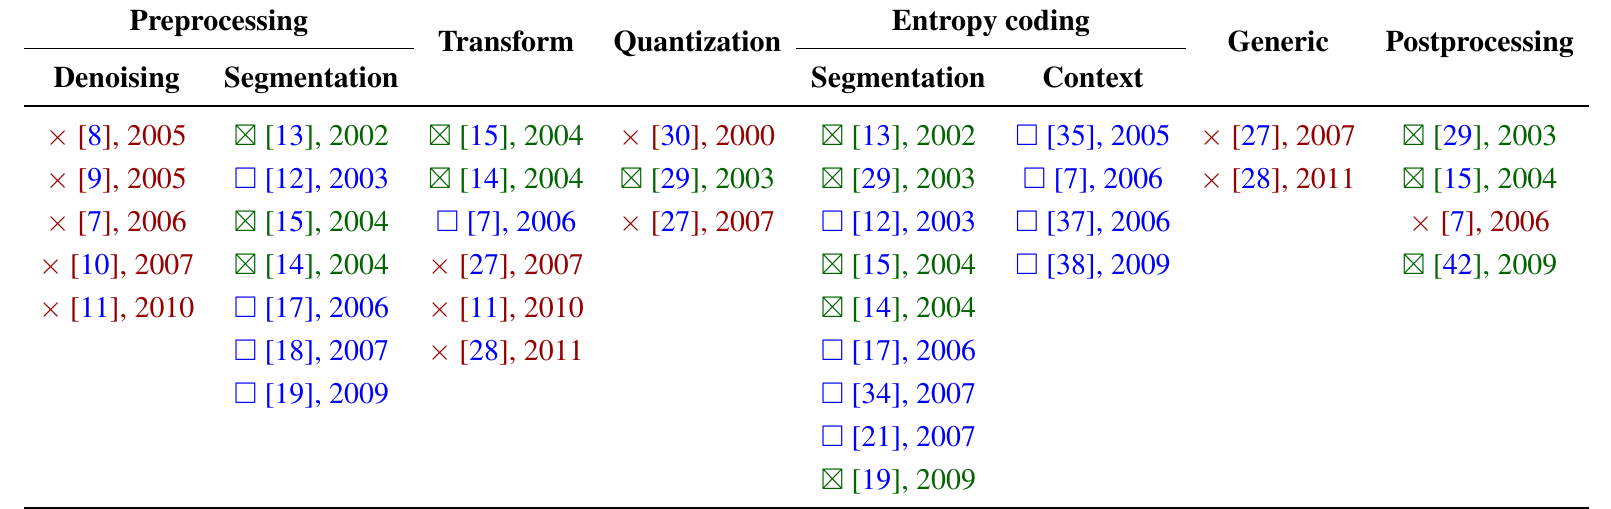
Table 1. Classification of microarray-specific techniques discussed in this document, attending to the compression stage where they make their contribution. Techniques are sorted chronologically and can appear in more than one category. Purely lossy methods are marked with red and × . Purely lossless with blue and (cid:3) . Lossy and lossless with green and (cid:2)